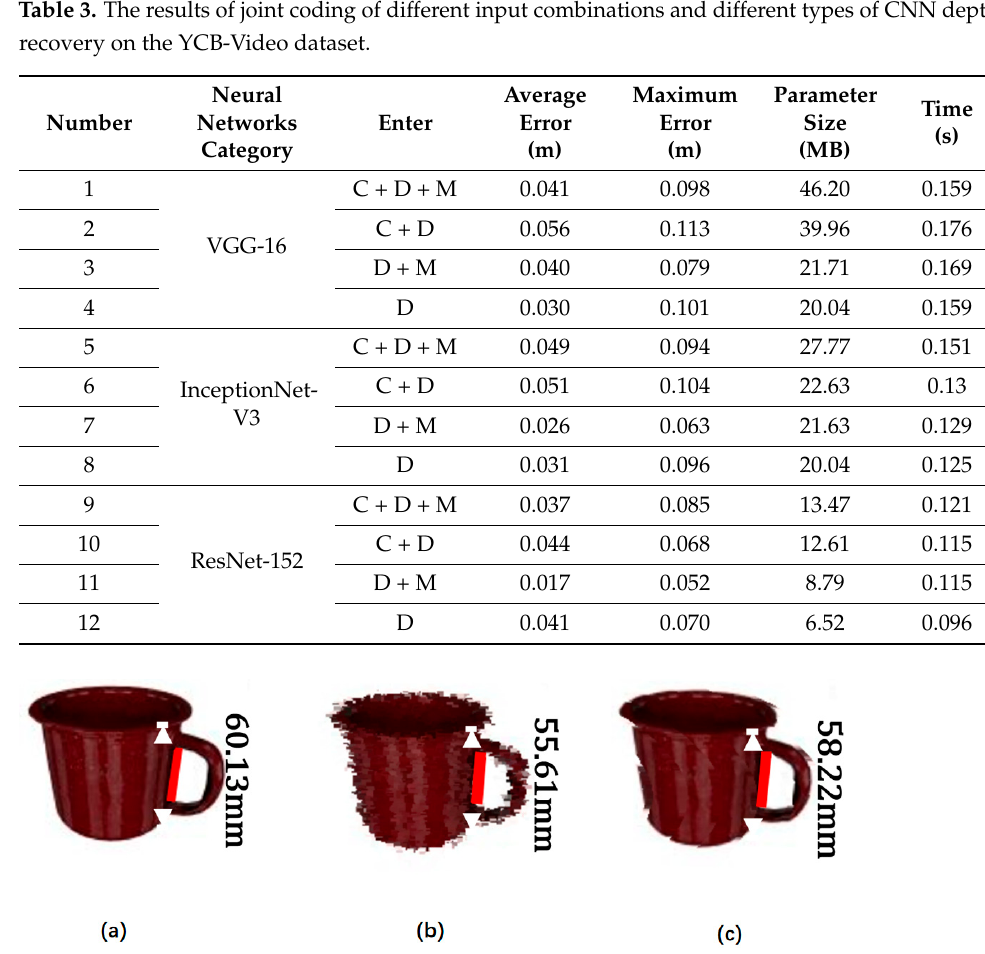
Figure 4. Comparison of teacup reconstruction models on YCB-Video dataset. ( a ) RGB image; ( b ) NN results; and ( c ) BCC-Drop